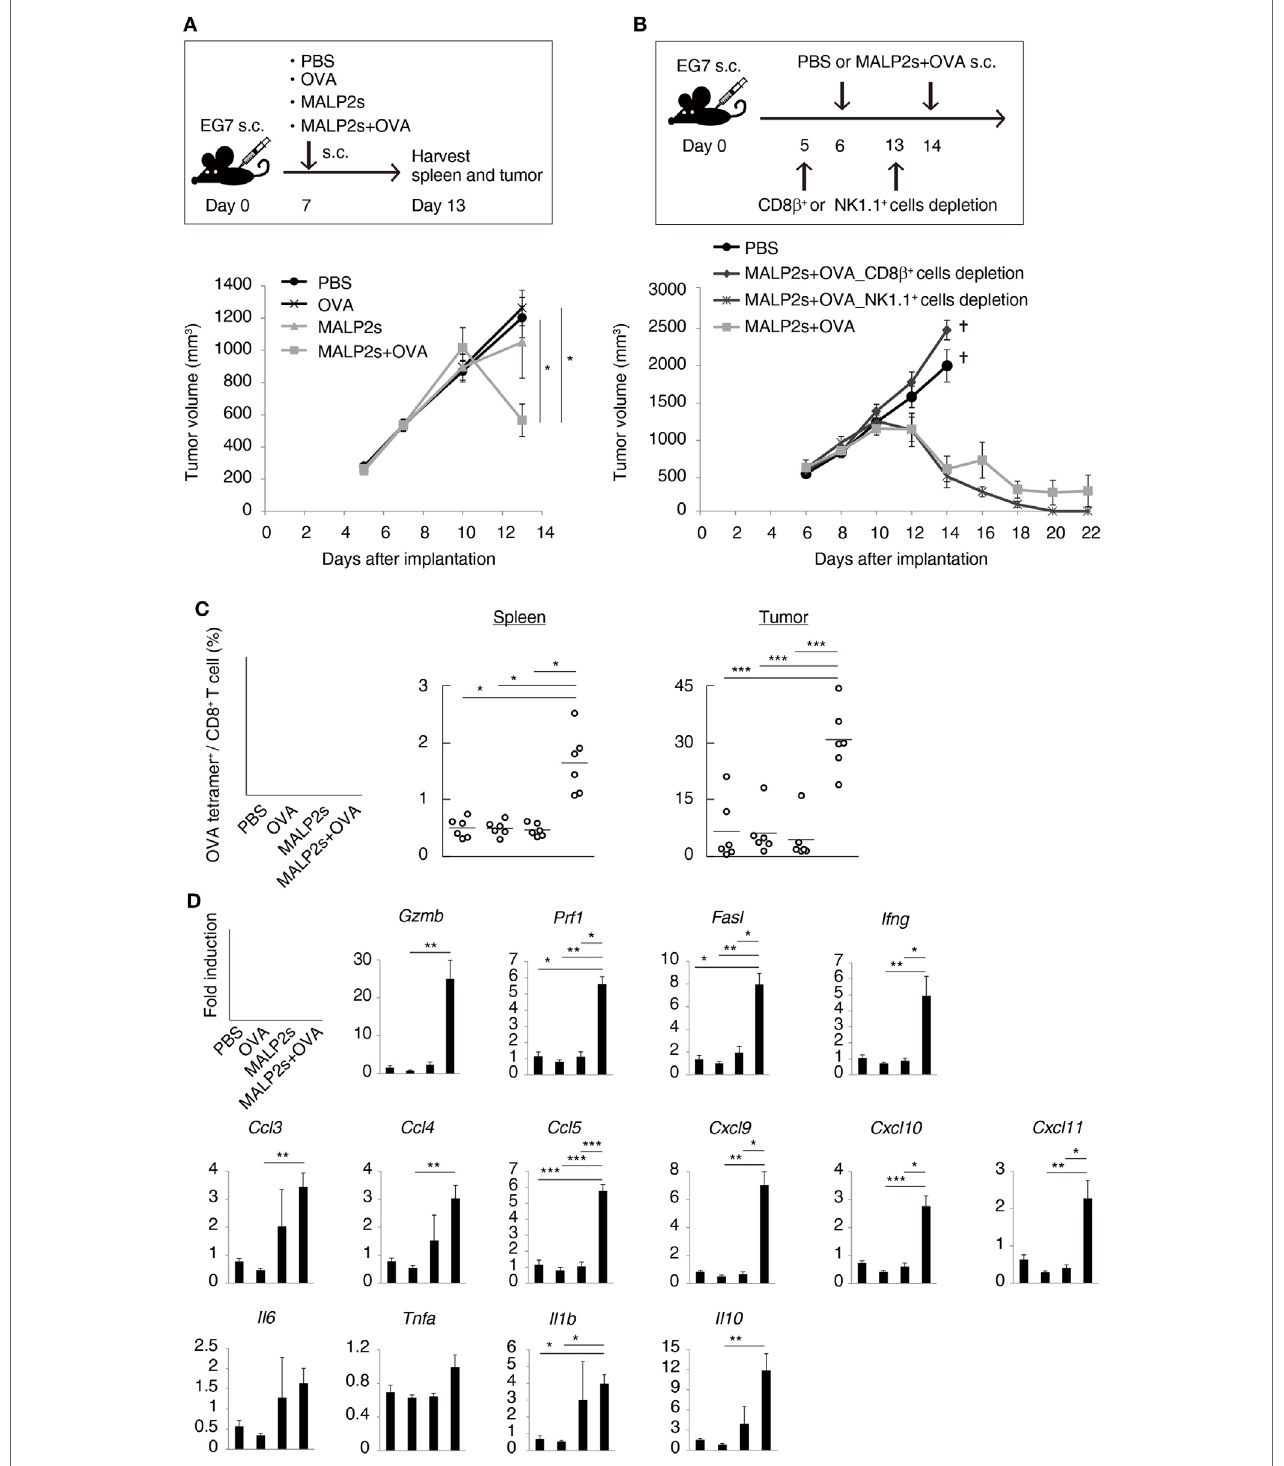
FigUre 3 | MALP2s with tumor-associated antigen regresses EG7 tumor in a cytotoxic T lymphocytes-dependent manner. (a,B) EG7-bearing mice were treated as in the upper schemes. A tumor volume was measured in each group (lower Figures). PBS and CD8 β + cells depletion groups of B were euthanized on day 14. (c,D) EG7-bearing mice of A were euthanized on day 13. (c) The percentages of OVA-specific cells among splenic and intratumor CD8 + T cells were analyzed by flow cytometry. (D) Gene expressions in tumor tissue were analyzed by qPCR. Error bars show ± SEM; n = 4–6 per group. Kruskal–Wallis test with Dunn’s multiple comparison test or One-way analysis of variance with Bonferroni’s test was performed to analyze statistical significance (* p < 0.05, ** p < 0.01 *** p < 0.001). (a,c) The results are representative of more than two independent experiments.